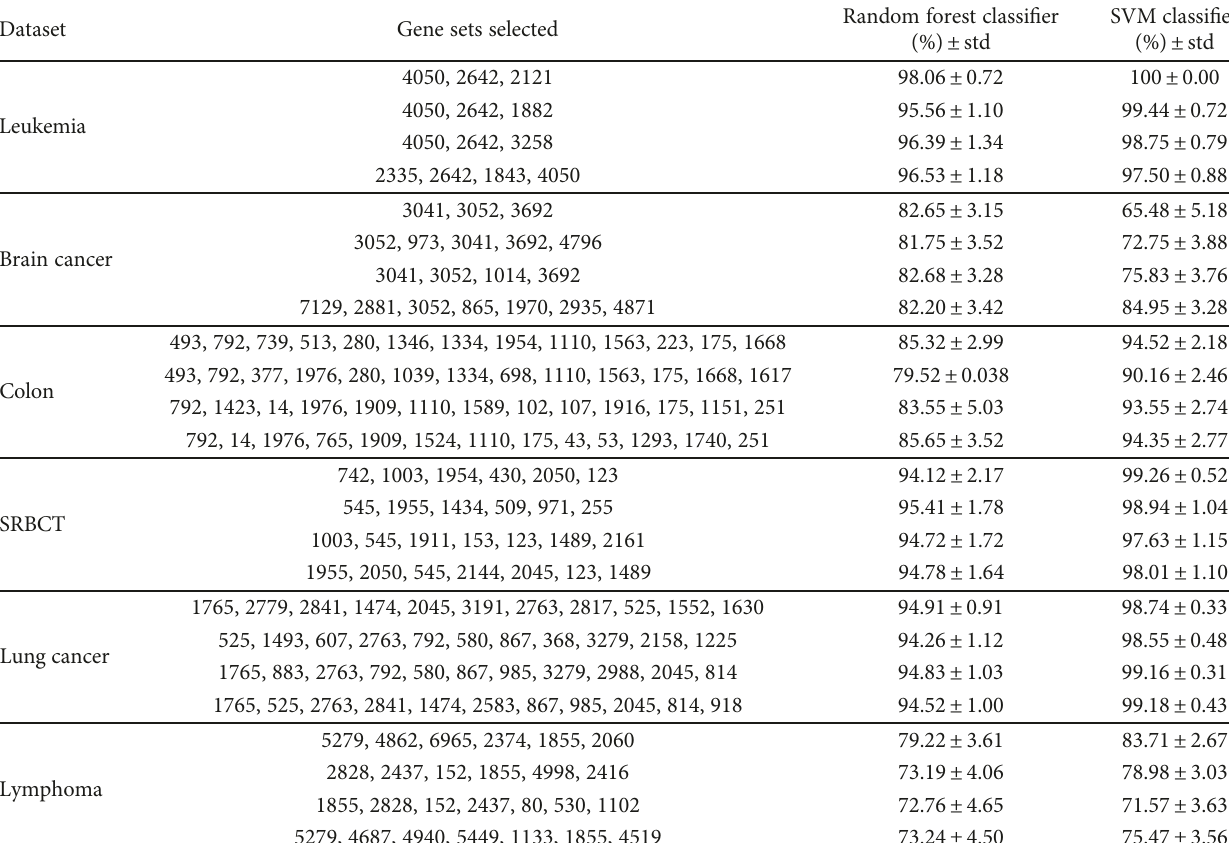
Table 8: Tumor disease recognition results of random forest classi fi er and SVM classi fi er.